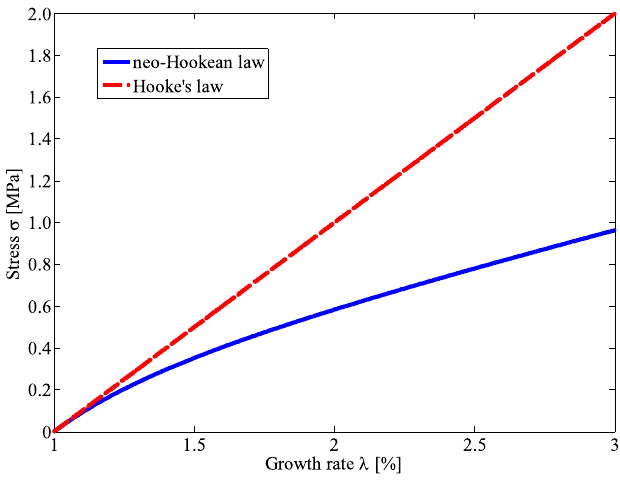
Figure 2. The comparison of neo-Hookean model and Hooke’s